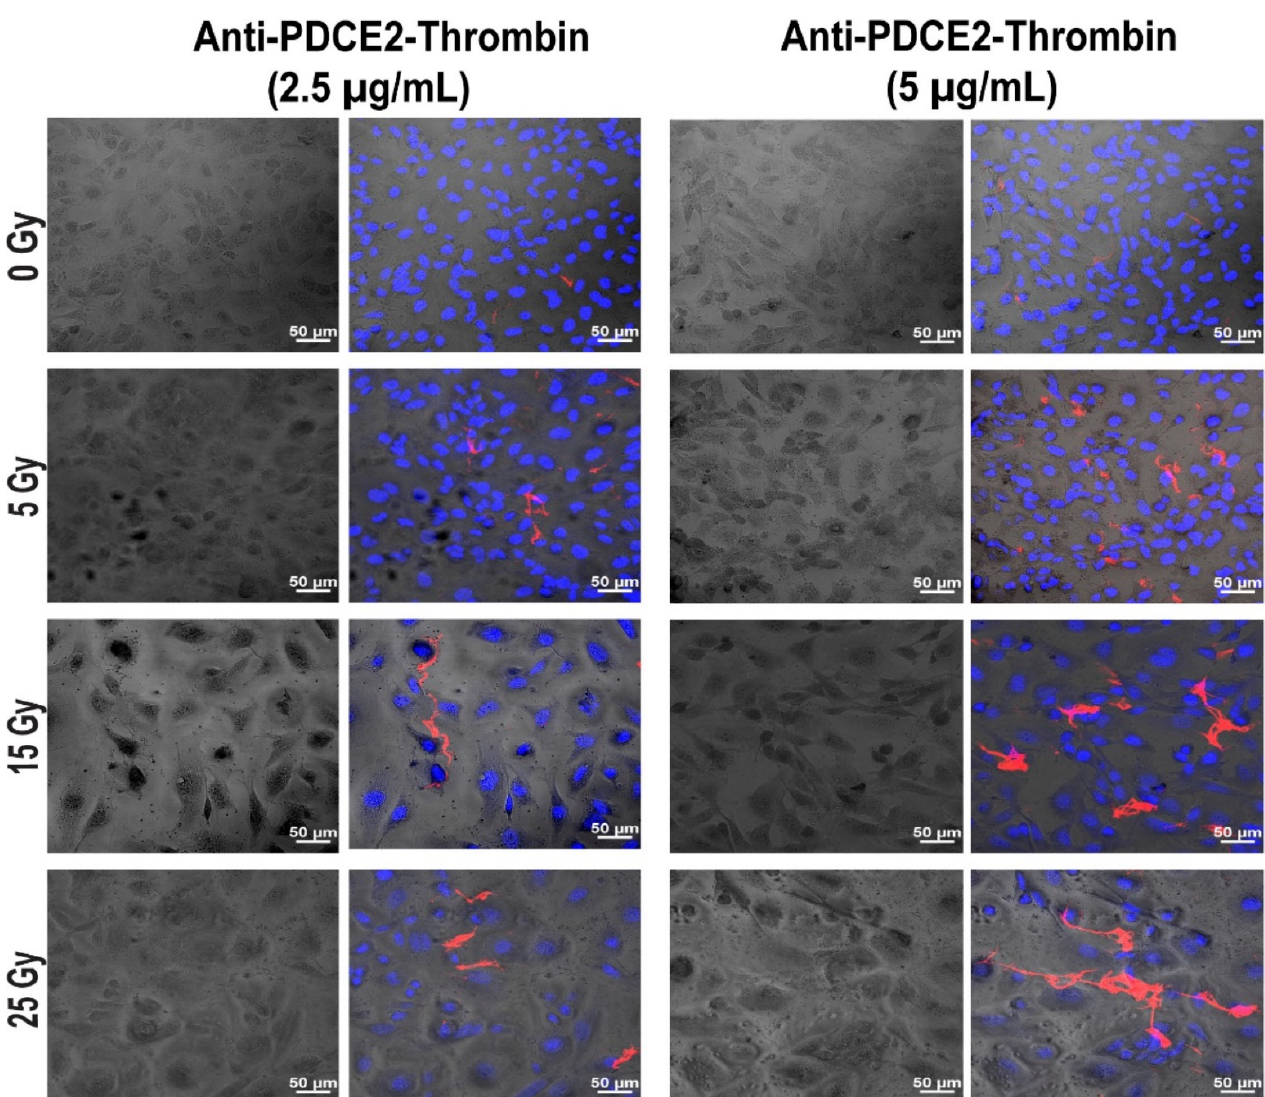
Figure 3. PDCE2-targeting coaguligand induces selective fibrin clot formation on irradiated cells in a parallel-plate flow system. Representative confocal images showing FITC-tagged fibrinogen (red) forming fibrin clots on confluent endothelial monolayers at day 2 post-irradiation (0, 5, 15 and 25 Gy) in the parallel-plate flow system containing whole human blood. Anti-PDCE2 antibody–thrombin coaguligands were injected into the circulation at concentrations of 2.5 and 5 µg/mL for 15 min. Nuclei were stained with Hoechst (blue). Cells were imaged with phase contrast microscopy. All images were captured at a magnification of 200× (Bar = 50 µm). It should be noted that in response to radiation, cell layers retain full confluence; however, as they undergo significant hypertrophy (cell and nuclear enlargement), fewer cells are observed per field of view.